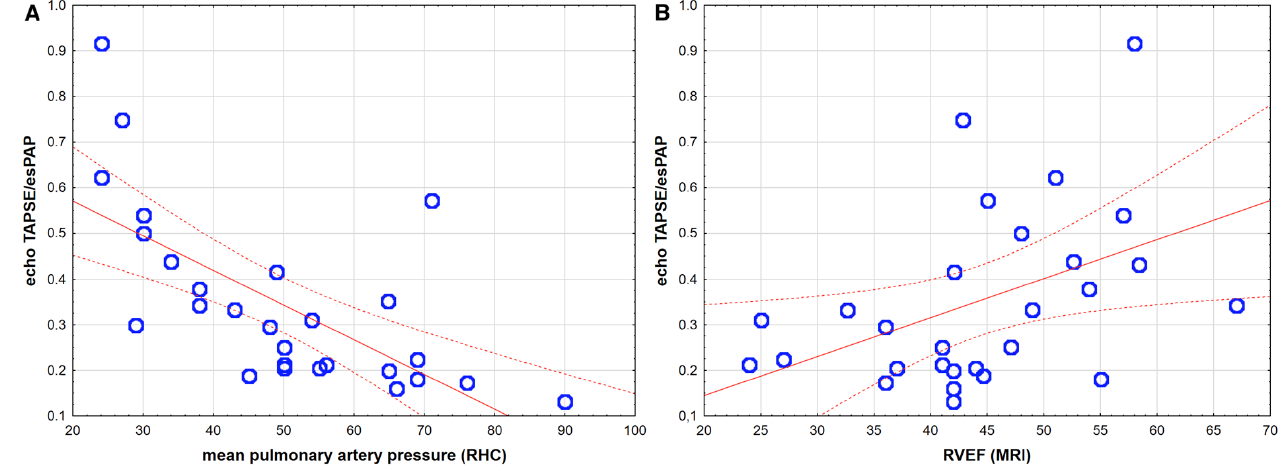
Figure 2. Spearman correlations between echo TAPSE/sPAP ratio and ( A ) mean pulmonary artery pressure, mPAP (r = − 0.72, p < 0.001) and ( B ) right ventricle ejection fraction, RVEF (r = 0.51, p = 0.01).